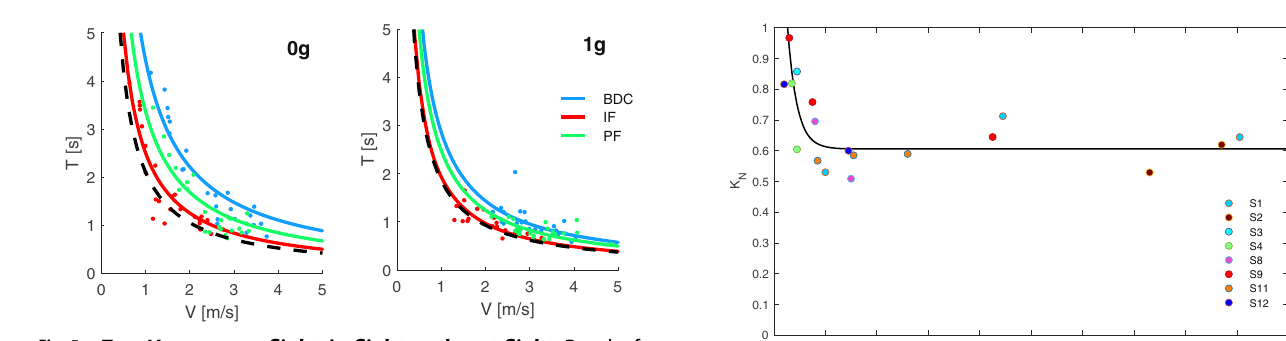
Fig. 5 T vs. V curves pre- fl ight, in- fl ight, and post- fl ight. Results for three different experiments (left to right, imaginary 0 g and 1 g ) performed pre- fl ight (blue), in- fl ight (red), and post- fl ight (green) by participant S11. Notice the shift of T - V curves in- fl ight closer to the dashed curves, which depict the predictions based on the hand-to- ceiling distance estimated for this subject in- fl ight. T versus V diagram: the smaller is K , the closer is the function to